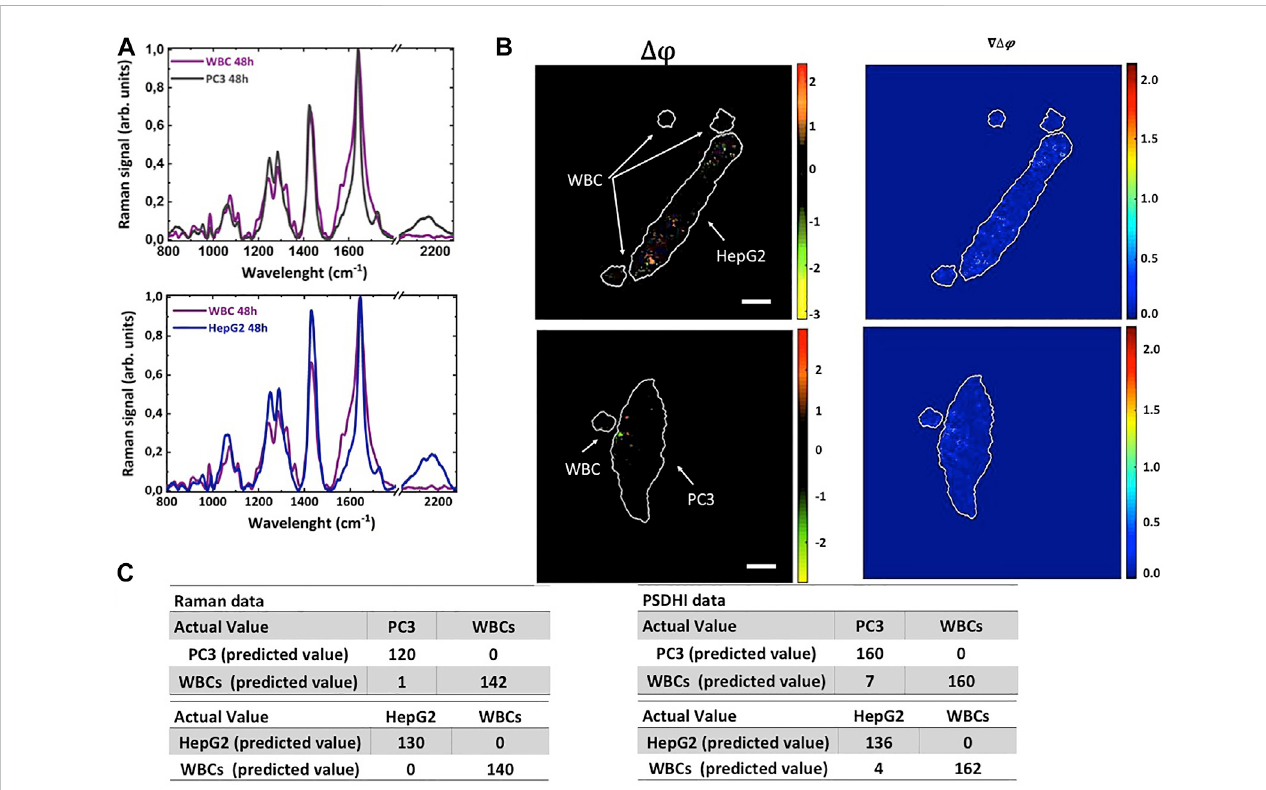
FIGURE 4 PSDHIandRamananalysisofHepG2andPC3cellsco-culturedwithWBCsisolatedfromperipheralbloodofhealthydonorsinpresenceof25 mMdeut- Glc for 48 h. (A) Raman spectra of PC3 (grey line), HepG2 (blue line) cells co-cultured with WBCs (purple line in both the graphs). (B) PSDHI maps for the co- cultures cancer cells and WBCs. The smaller WBCs do not show signi fi cant birefringence variation compared to both HepG2 and PC3 cancer cell lines. (C) Results of the classi fi cation algorithm by Raman and PSDHI dataset of HepG2 and PC3 cells co-cultured with